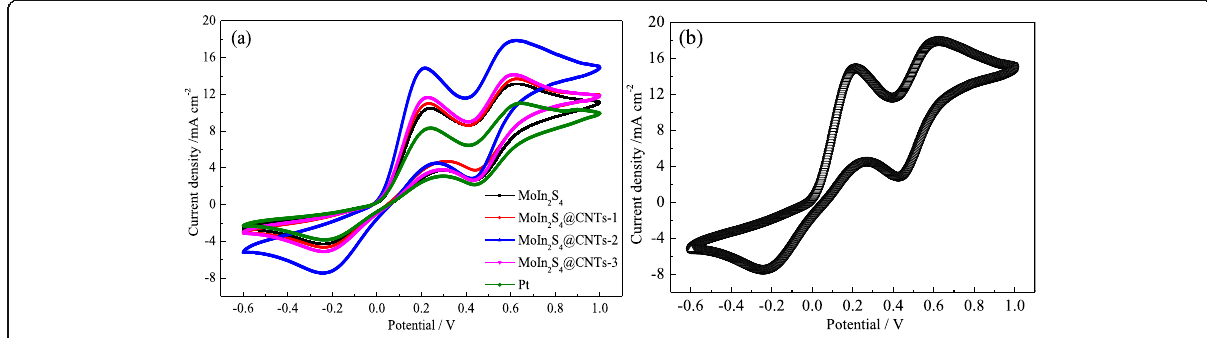
Fig. 5 a CVs of the various CEs at a scan rate of 60 mV s − 1 . b 50 cycles CV of the MoIn 2 S 4 @CNTs-2 CE